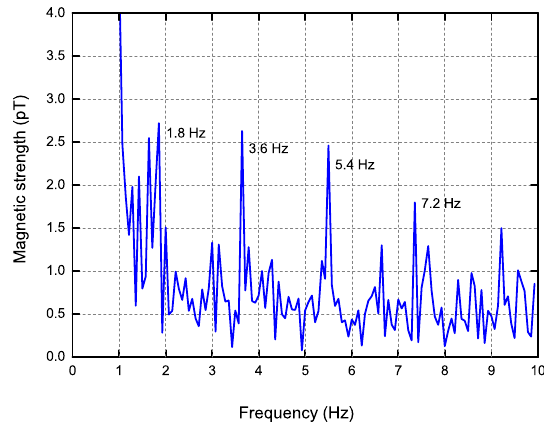
Figure 8. The measured magnetic strength at distance of 1300